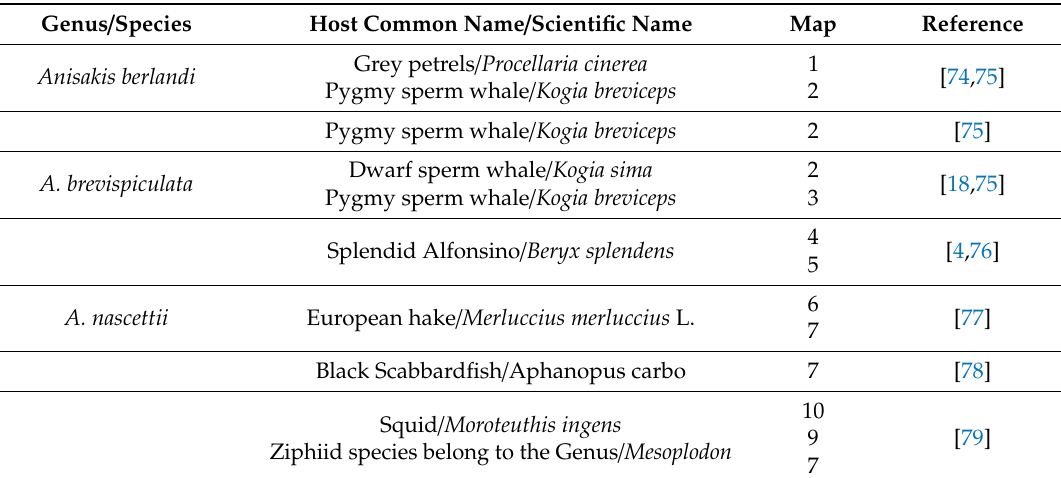
Table 1. Genus and species that make up the Anisakidae family, described and identified by morphology / molecular and molecular tests, isolated from various